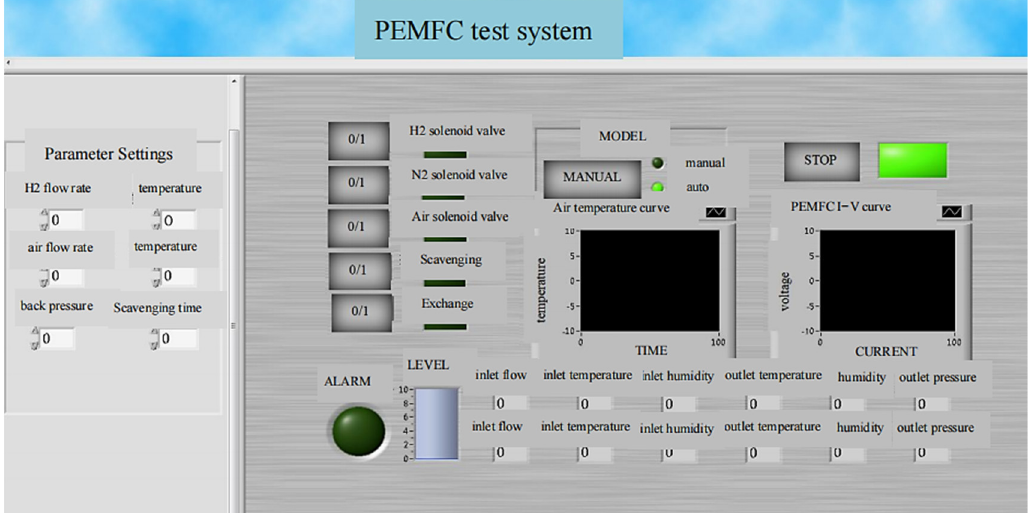
Figure 9. LabVIEW human–machine interface.